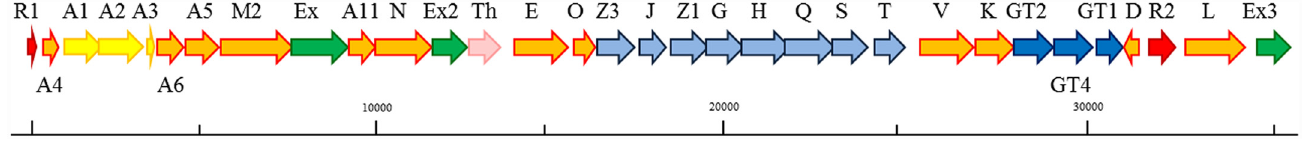
Fig 2. Grecocycline biosynthetic gene cluster ( gre ) from S . sp. Acta 13 – 62. In yellow are labeled genes encoding type II PKS, orange — genes involved in angucycline formation, blue — genes involved in biosynthesis of rhodinose and α -tolyposamine, dark blue — genes encoding glycosyltransferases, pink — gene encoding putative thioesterase, green — efflux, red — regulatory genes. Dashed arrow indicates formation of shunt product grecocycline C.